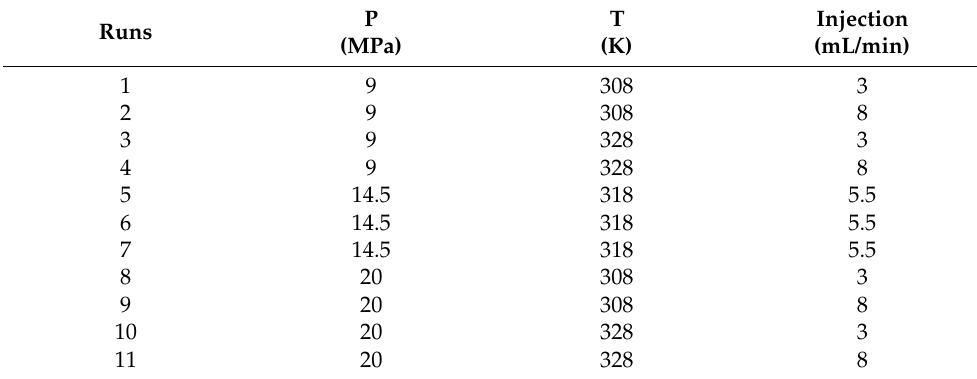
Table 1. Summary of the SAE experiments completed.